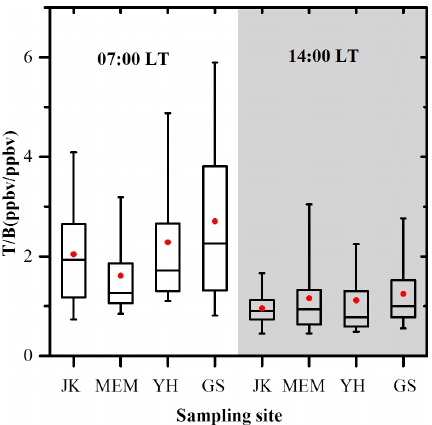
Figure 14. The average ratio of T/B at 07:00 and 14:00LT for each site during the whole sampling